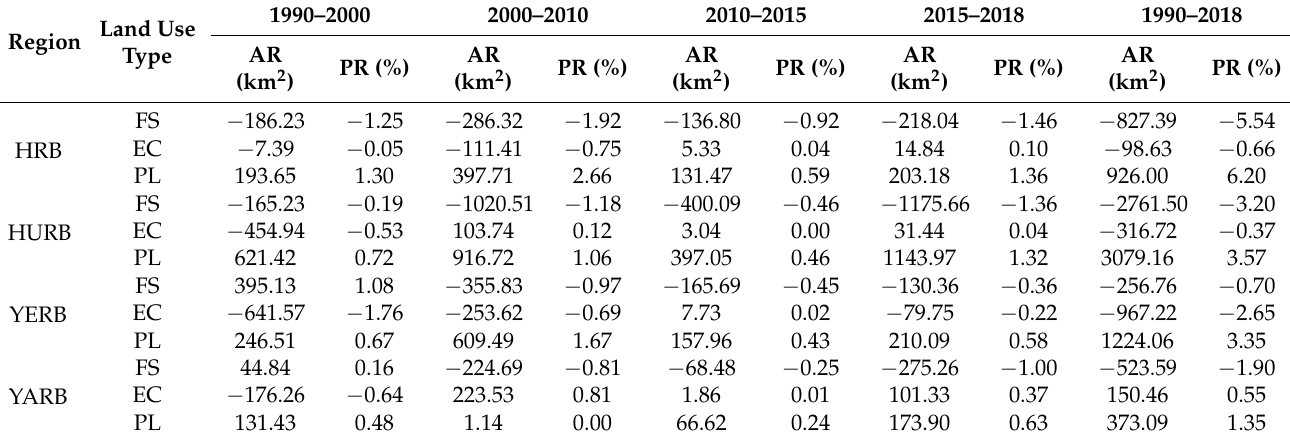
Table 4. Quantity and proportion of changes to types of land use in the study area during